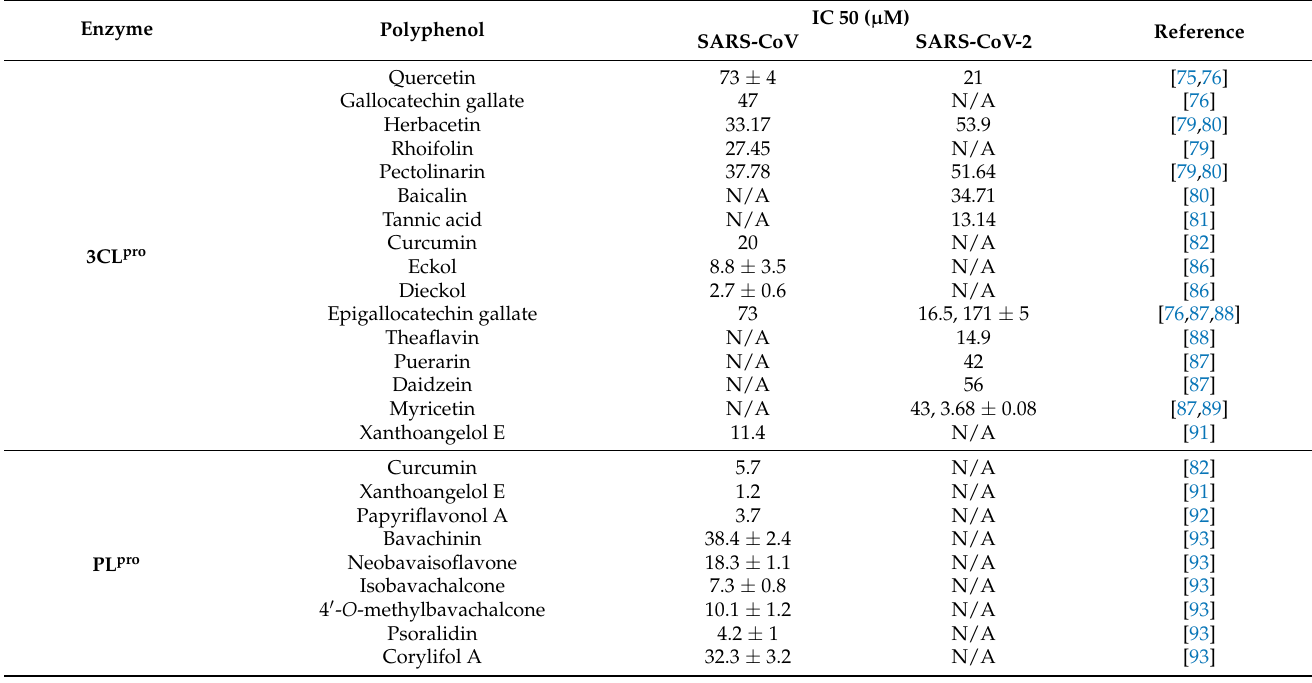
Table 2. In vitro IC 50 values for different polyphenols against 3CL pro and PL pro.